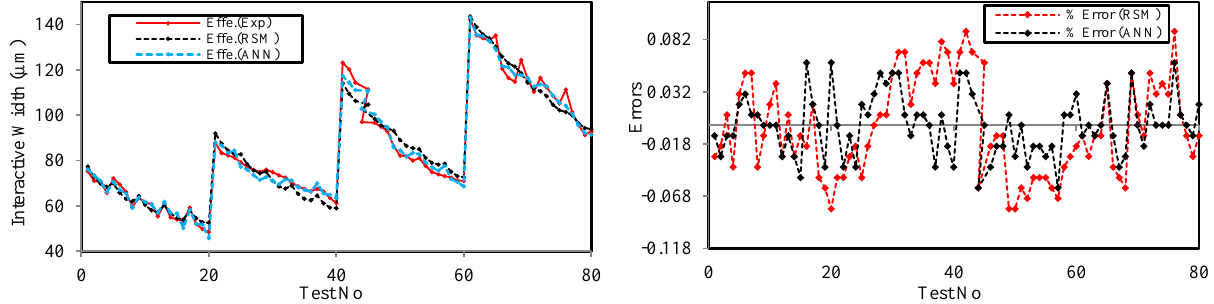
Fig. 4. Ra and % Errors comparison for the ANN and RSM